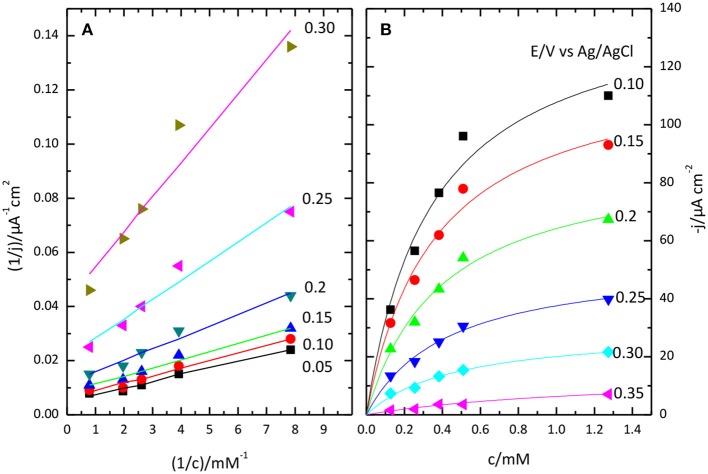
Lineweaver-Burk plot (A) and Michaelis-Menten plot (B) showing the effect of O2 concentration on catalytic current sodium PBS, pH 6.5.